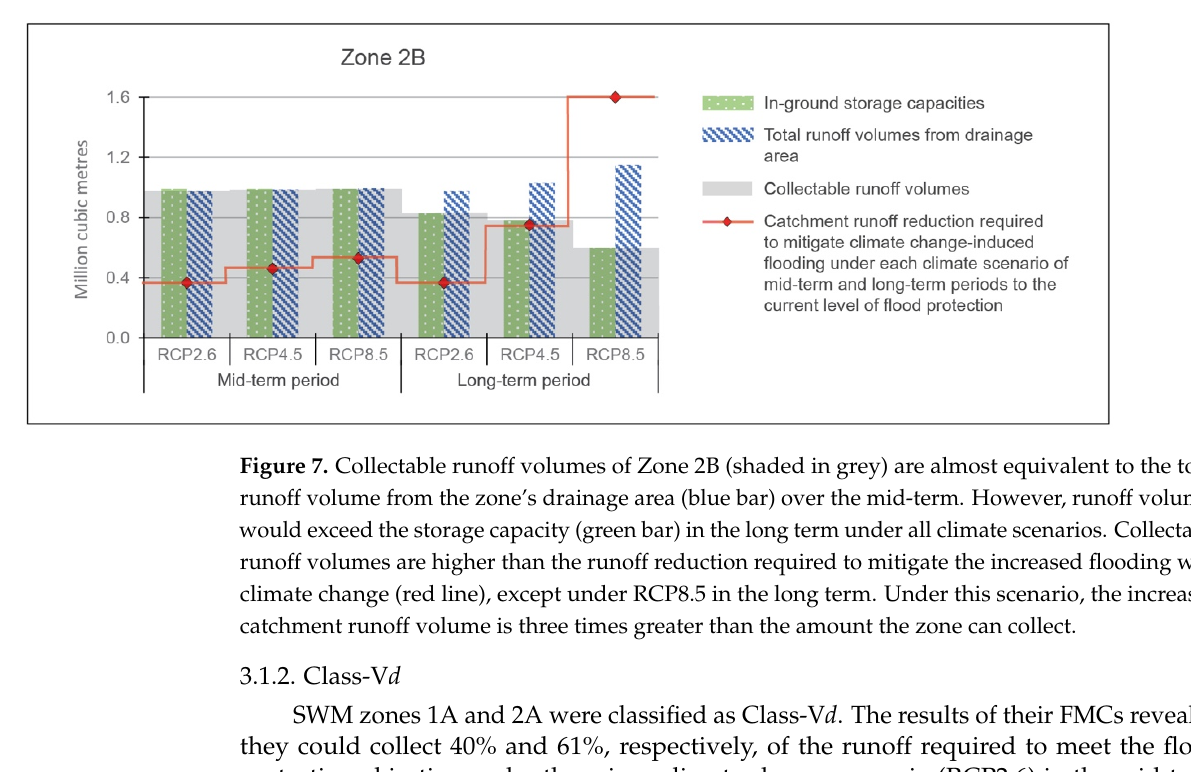
Figure 7. Collectable runoff volumes of Zone 2B (shaded in grey) are almost equivalent to the total runoff volume from the zone’s drainage area (blue bar) over the mid-term. However, runoff vol- umes would exceed the storage capacity (green bar) in the long term under all climate scenarios. Collectable runoff volumes are higher than the runoff reduction required to mitigate the increased flooding with climate change (red line), except under RCP8.5 in the long term. Under this scenario, the increased catchment runoff volume is three times greater than the amount the zone can collect.